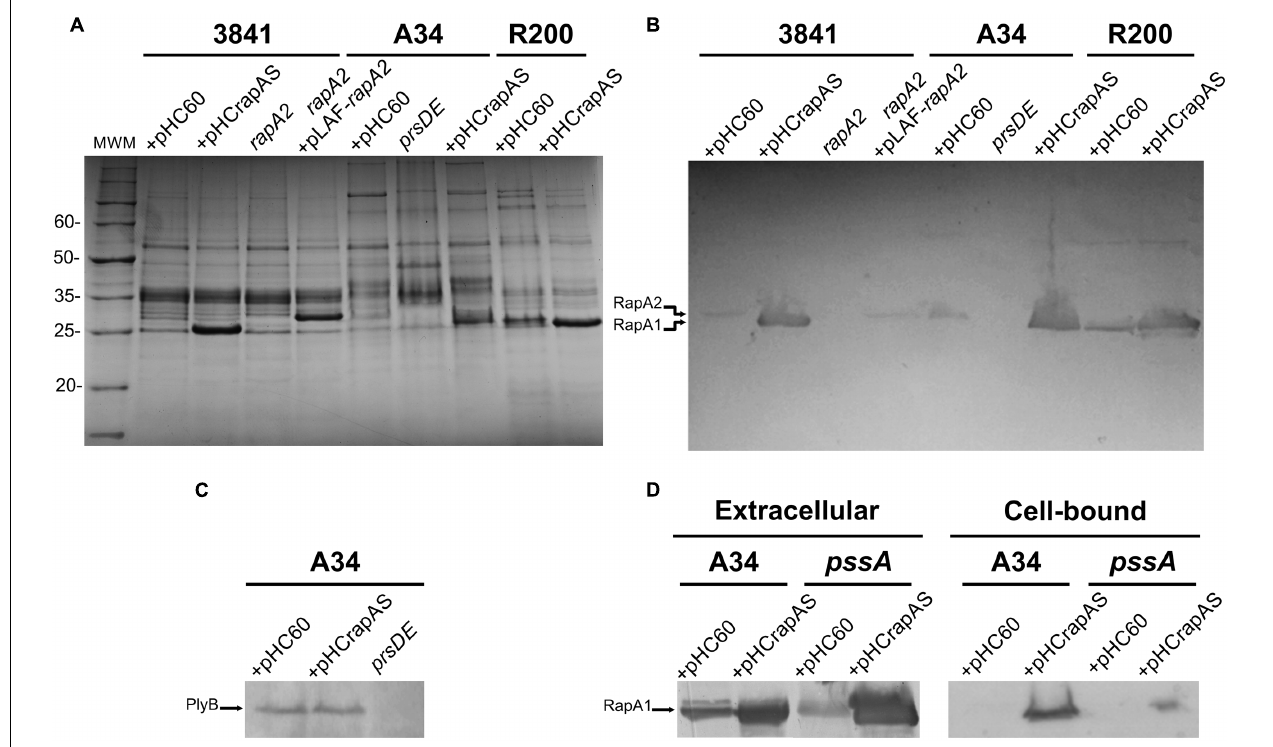
FIGURE 1 | Analysis of proteins secreted by the different genetic backgrounds. (A) Extracellular proteins were precipitated from culture supernatants, separated by SDS-PAGE and visualized by Coomassie blue staining. The strains analyzed were: 3841, A34, and R200 wild type strains harboring the pHC60 empty vector or pHCrapAS, the rapA2 mutant (in the 3841 background), the rapA2 mutant complemented with the pLAF- rapA2 plasmid, and the prsD secretion mutant. (B) Western blot using antibodies against the RapA1 protein. The arrows indicate bands corresponding to the RapA1 and RapA2 proteins. (C) PlyB secretion in the A34 background containing pHC60 or pHCrapAS was analyzed by Western blot using antibodies raised against the glycanase PlyB. The arrow indicates the PlyB protein band. (D) Western blot analysis of extracellular and surface-associated proteins from the pssA mutant harboring either pHC60 or pHCrapAS. Membranes were incubated with the anti-RapA1 antiserum. Representative blots are shown from three different protein preparations. Total protein was standardized using equal amounts of cultures with similar OD at 600 nm.